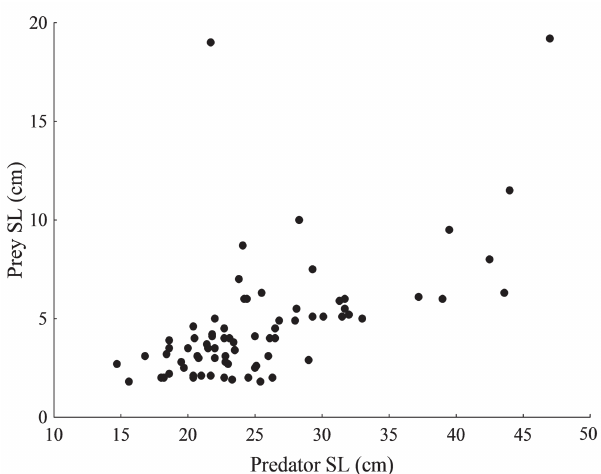
Fig. 3. Relationship between the size (standard length SL, cm) of Cichla piquiti and its prey.